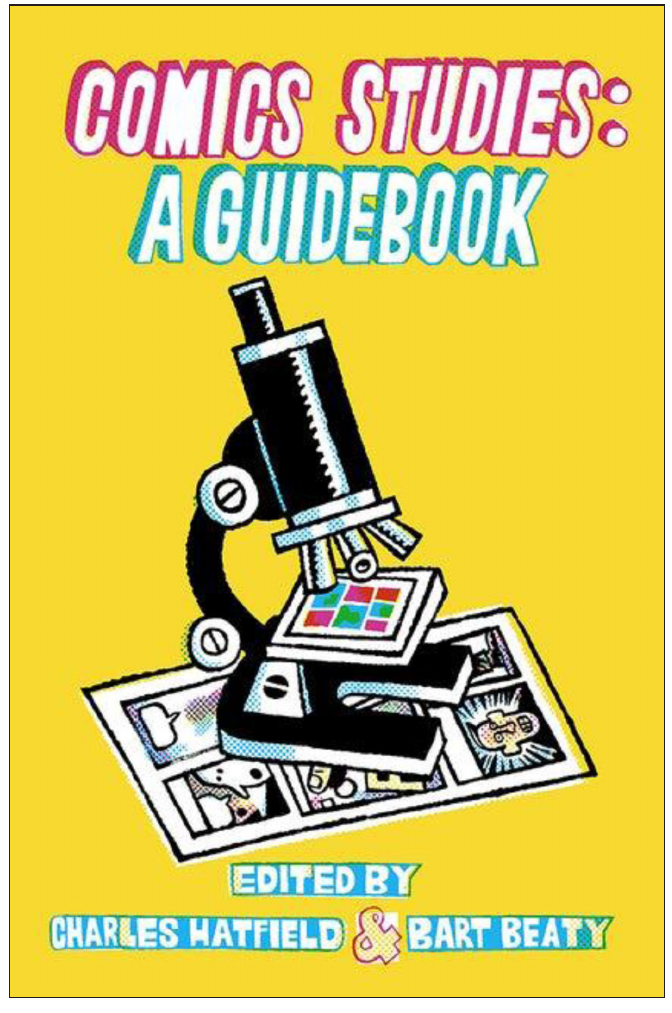
Figure 1: Cover of Comics Studies: A Guidebook (2020) © Rutgers University